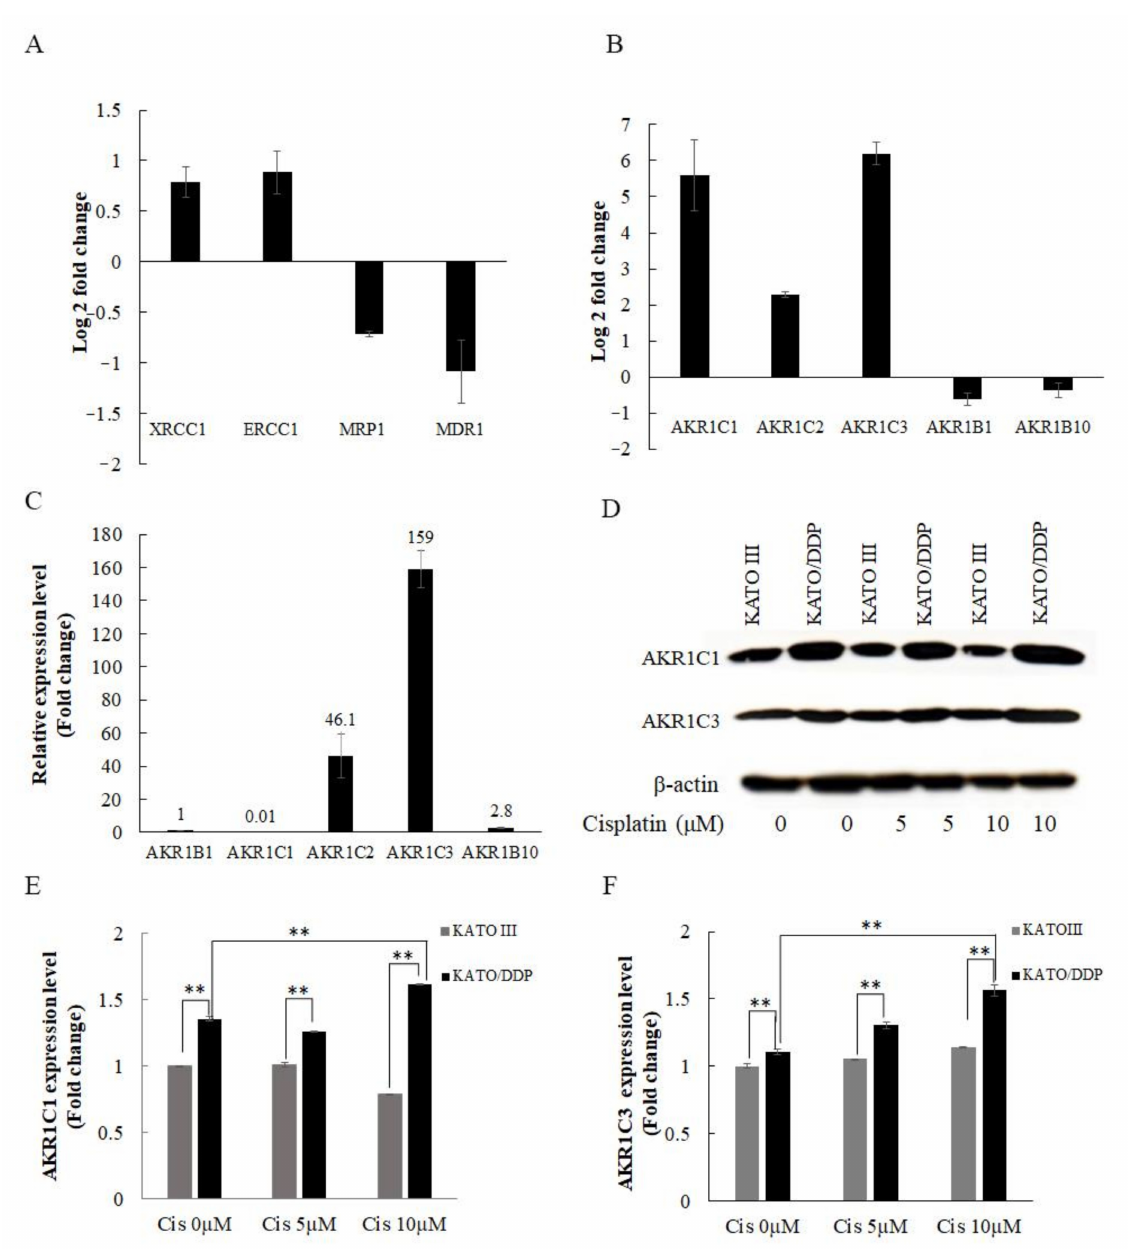
Figure 5. Determination of cisplatin resistance related genes in SRCGC. ( A ) Fold-change difference in expression of known drug-resistance-related genes between KATO/DDP and KATOIII gastric cancer cell lines by qPCR. ( B ) Fold-change difference in expression of aldoketoreductase family between KATO/DDP and KATOIII gastric cancer cell line by qPCR. ( C ) Relative expression of aldoketoreductase family in KATO/DDP cell line. ( D ) KATO/DDP and KATOIII gastric cancer cell lines were treated with different concentration of cisplatin (0–10 µ M) for 24 h. The expression levels of AKR1C1 and AKR1C3 were detected by Western Blot analysis. ( E ) Quantitative representation of AKR1C1 protein expression by Western blot. ( F ) Quantitative representation of AKR1C3 protein expression by Western blot analysis. Data are presented in mean ± SD; ** represents p <